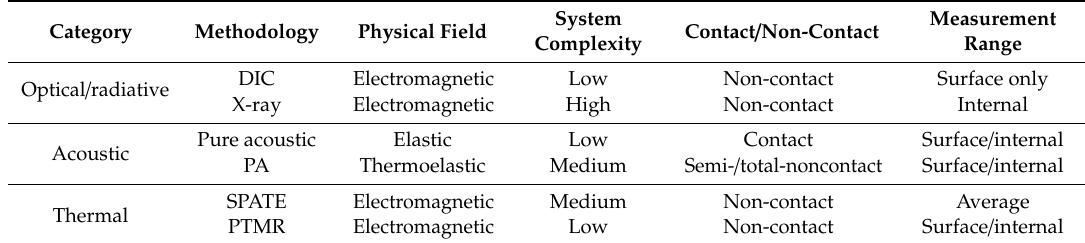
Table 1. Summary of popular stress-strain NDT / NDE